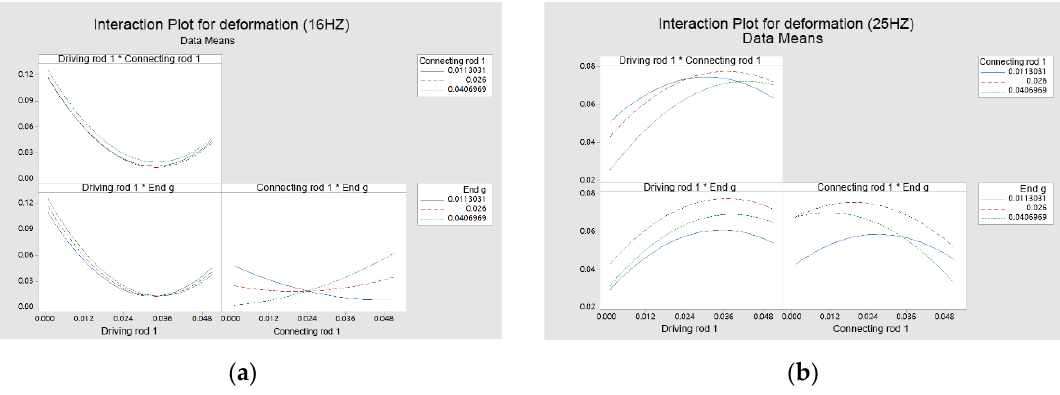
Figure 20. Interaction diagrams of the amplitude displacement at the end of the welding robot: ( a ) 16 Hz;( b ) 18 Hz. (The sign * in the figure means the interaction of two factors).